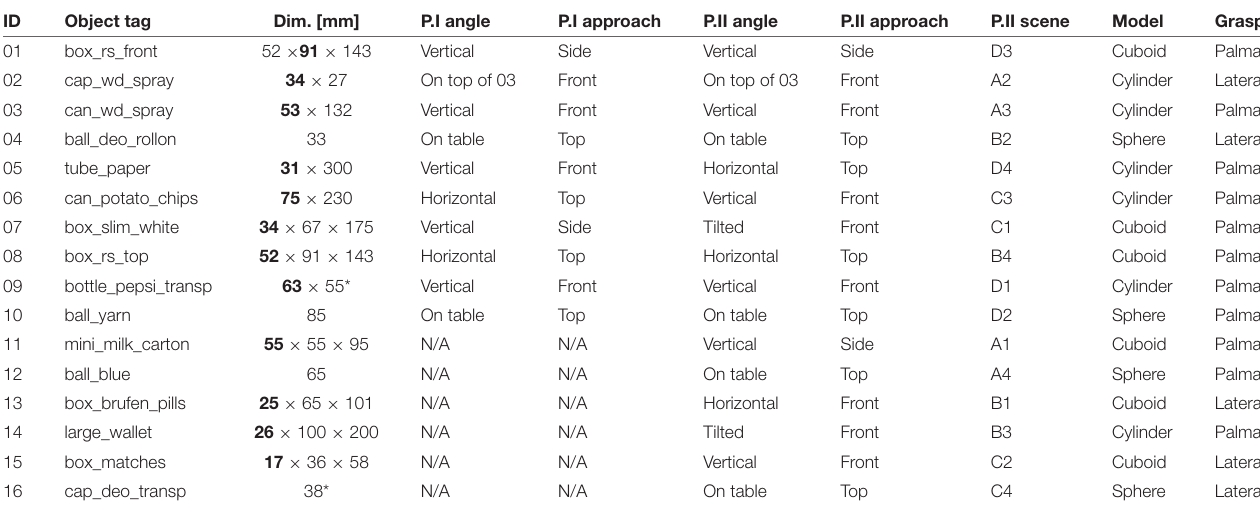
TABLE 1 | List of objects used in the